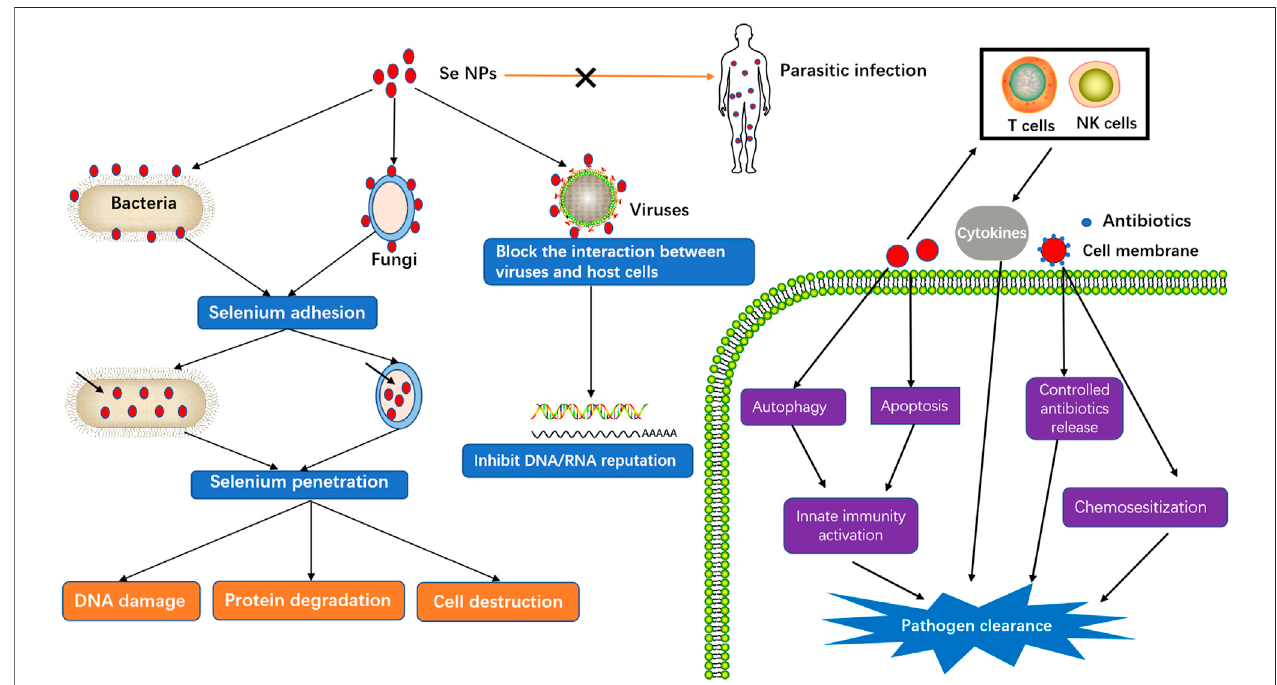
FIGURE 3 | Killing effects of Se NPs against